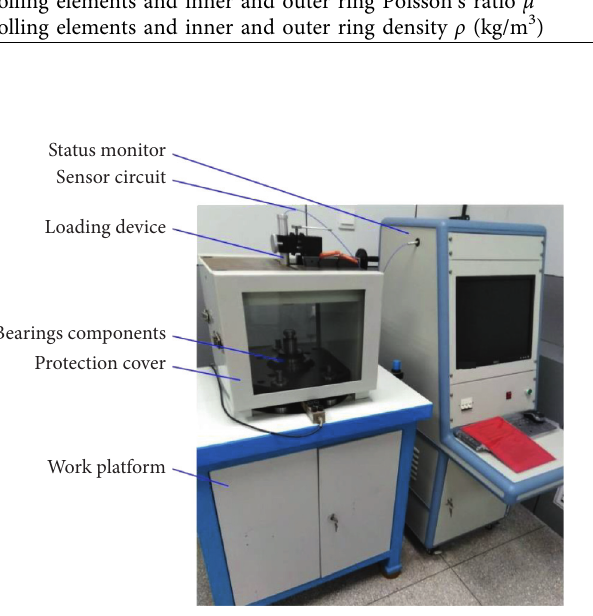
Figure 12: Bearing dynamic stiffness